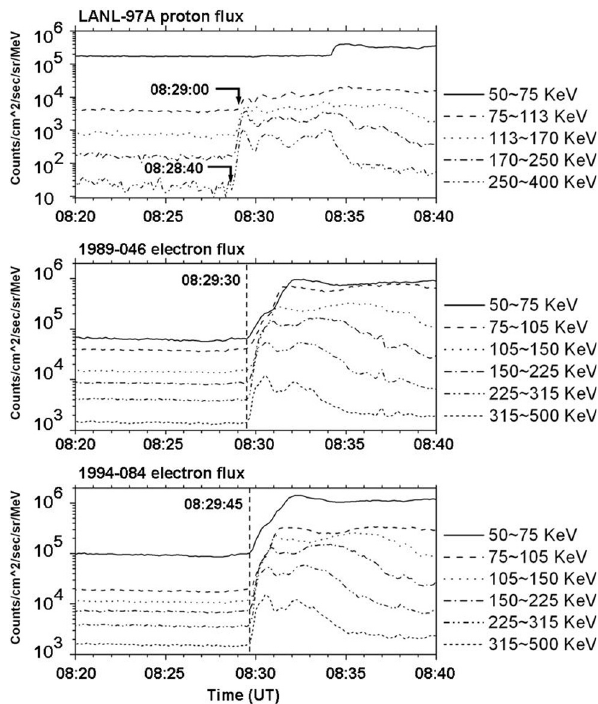
Fig. 13. The energetic particle injection observed by geosyn- chronous satellites during the 21 December 2006 substorm